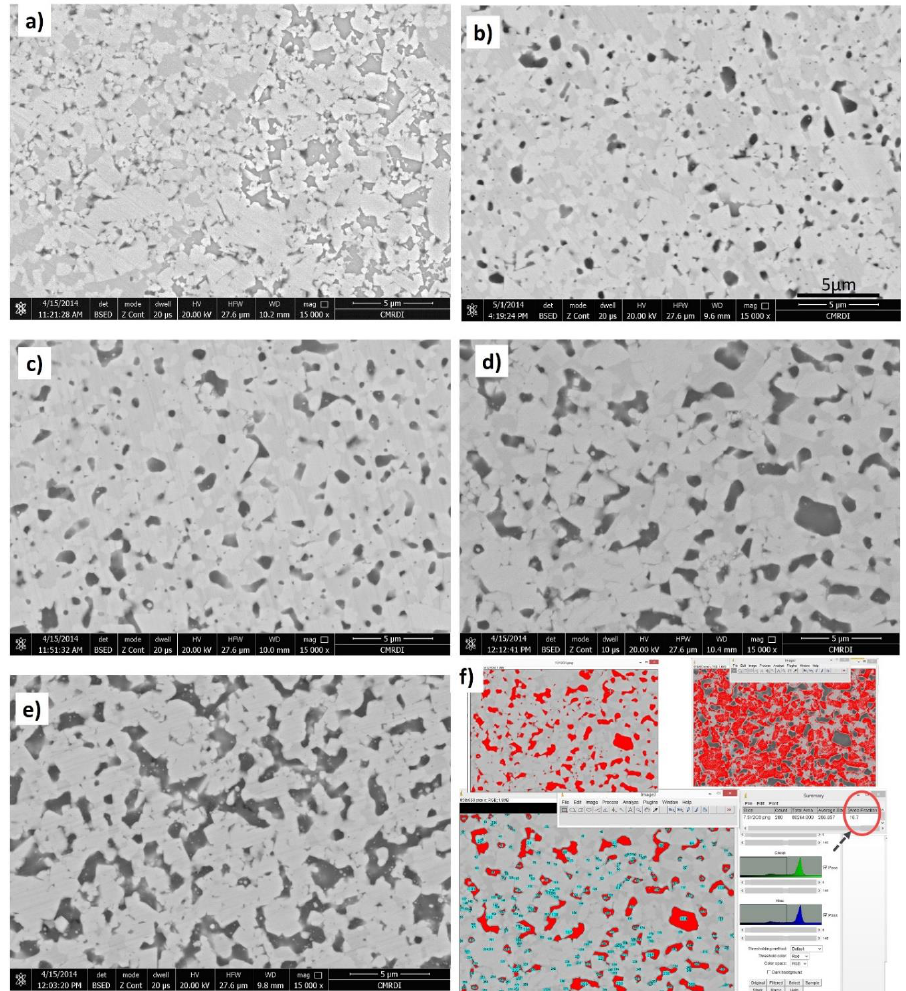
Figure 8. SEM micrographs of the consolidated WC-Co-TaC-NbC with different Y 2 O 3 content. ( a ) 0 wt% Y 2 O 3 , ( b ) 2.5 wt% Y 2 O 3 , ( c ) 5 wt% Y 2 O 3 , ( d ) 7.5 wt% Y 2 O 3 , ( e ) 10 wt% Y 2 O 3 , and ( f ) image processing of the SEM micrograph in ( d ) for area fraction calculation.